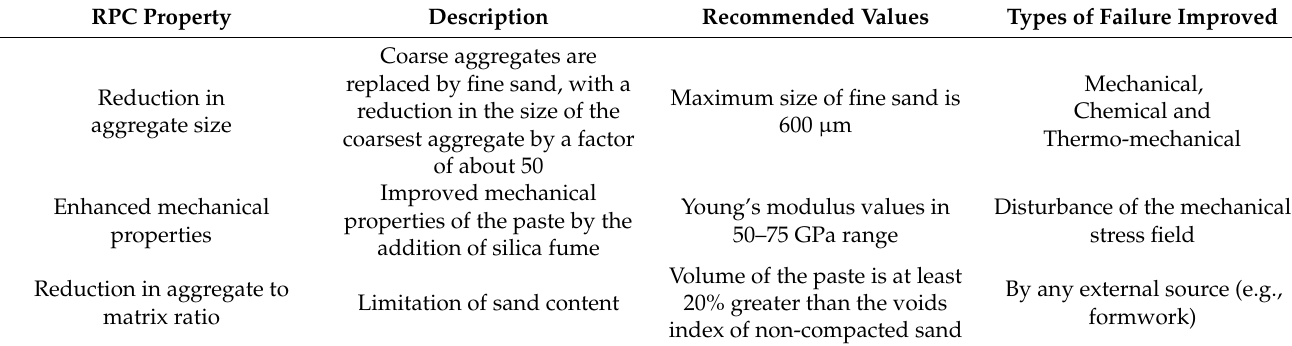
Table 3. Main properties of reactive powder concrete and recommended values